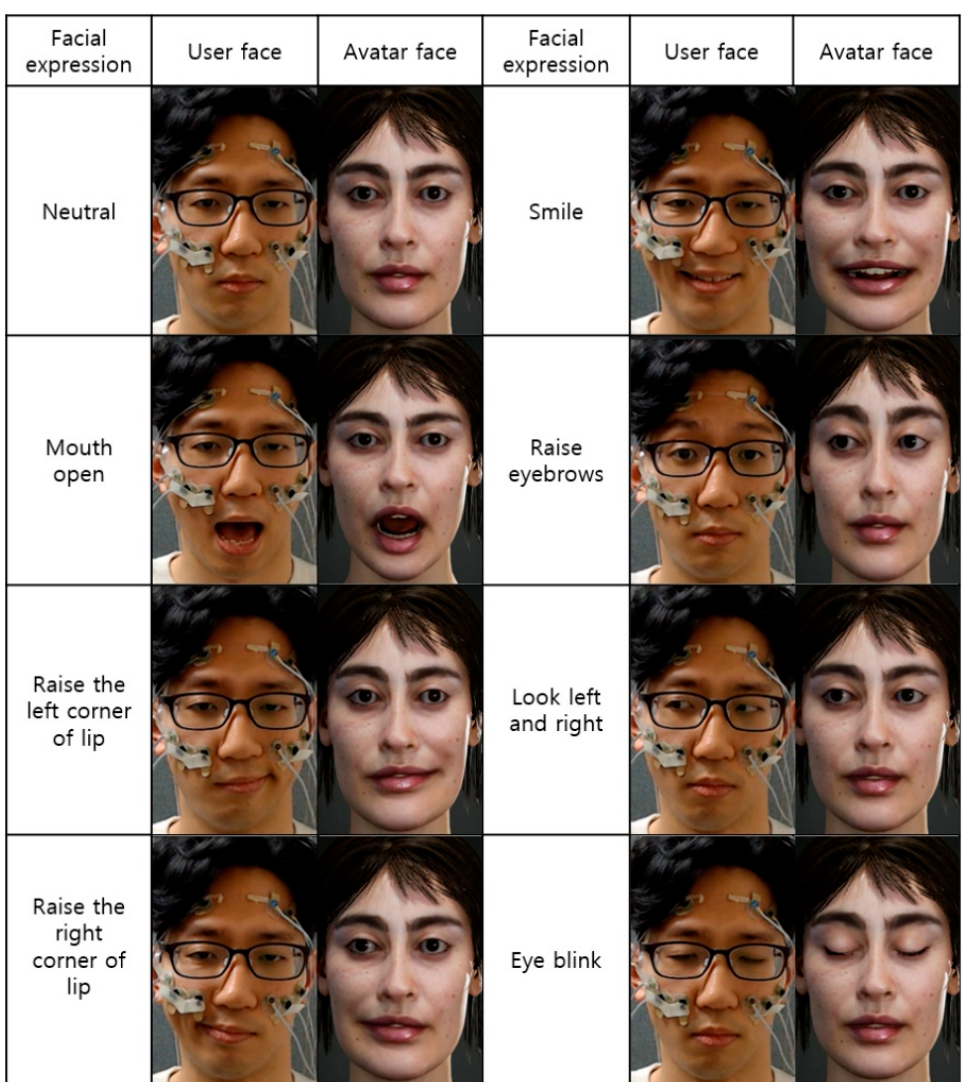
Figure 6. Comparison between actual face and predicted avatar face.